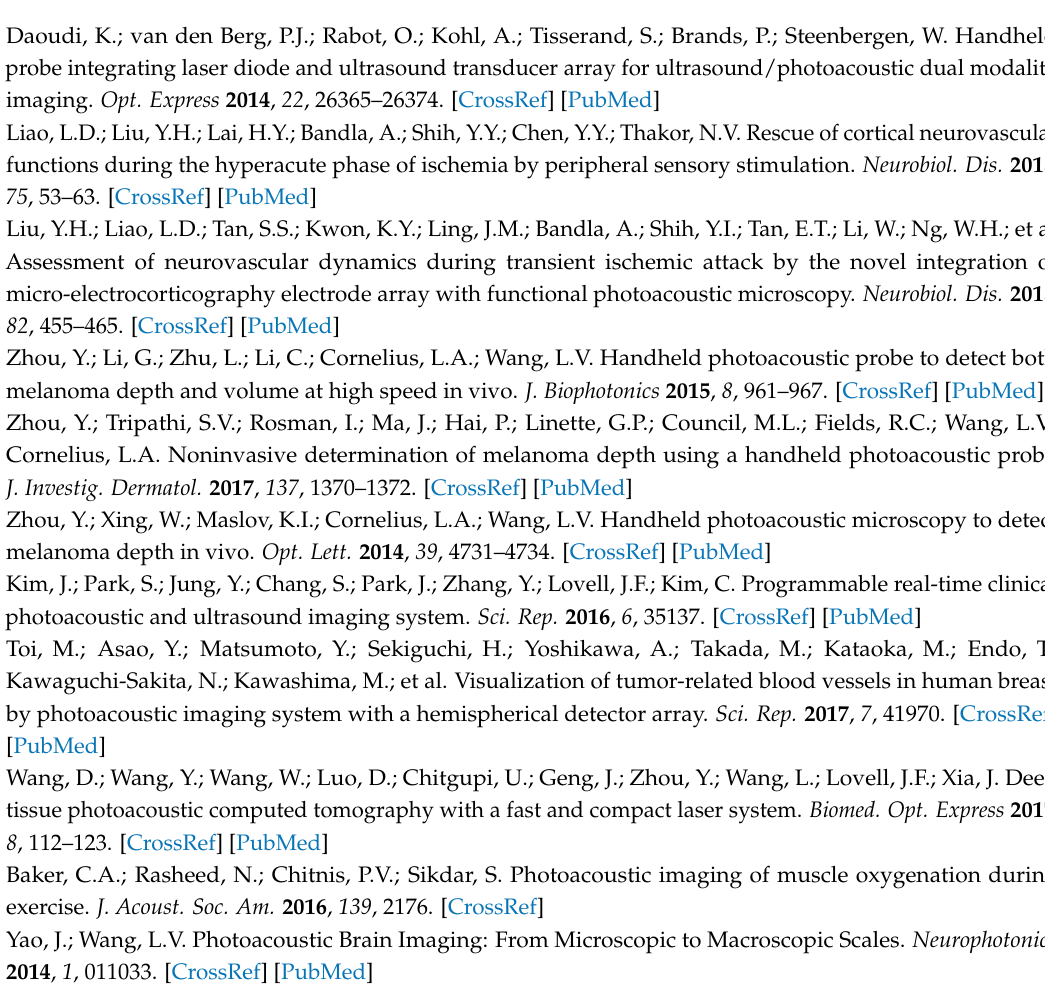
18/11/4081/s1, Figure S1: Schematic of the simulation procedures using the FEM method, Figure S2: Schematic of the customized fiber bundle, Figure S3: Schematic of the light propagation in water and the results of simulations, and Figure S4: Reconstructed PA images of the designed phantom consisting of three